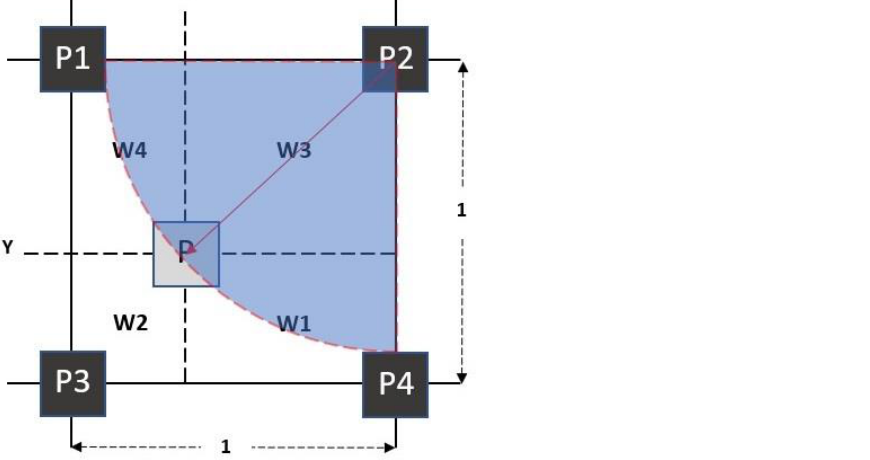
Figure 4. Example showing the hypotenuse-based radius for the weighting scheme—this is the HR weighting scheme.